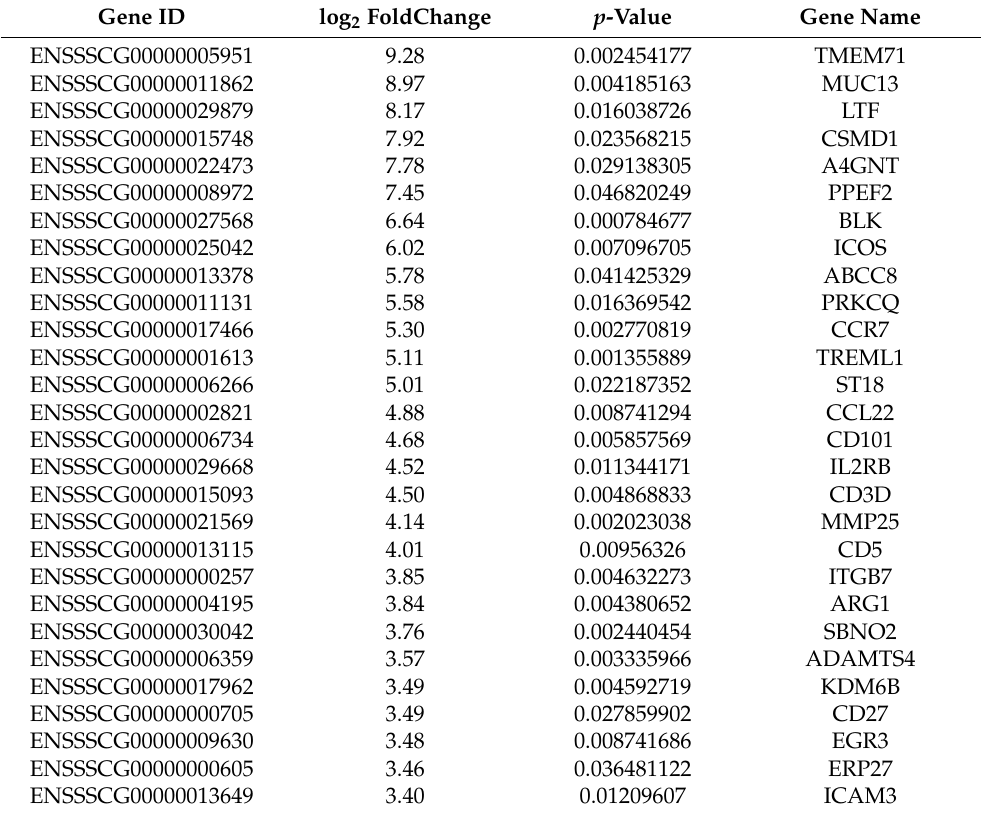
Table 4. Differentially expressed genes (DEGs) while comparing contralateral FA with scrambled peptide treated AVF FA (+value = higher expression in AVF FA treated with scrambled peptide; − value = higher expression in contralateral